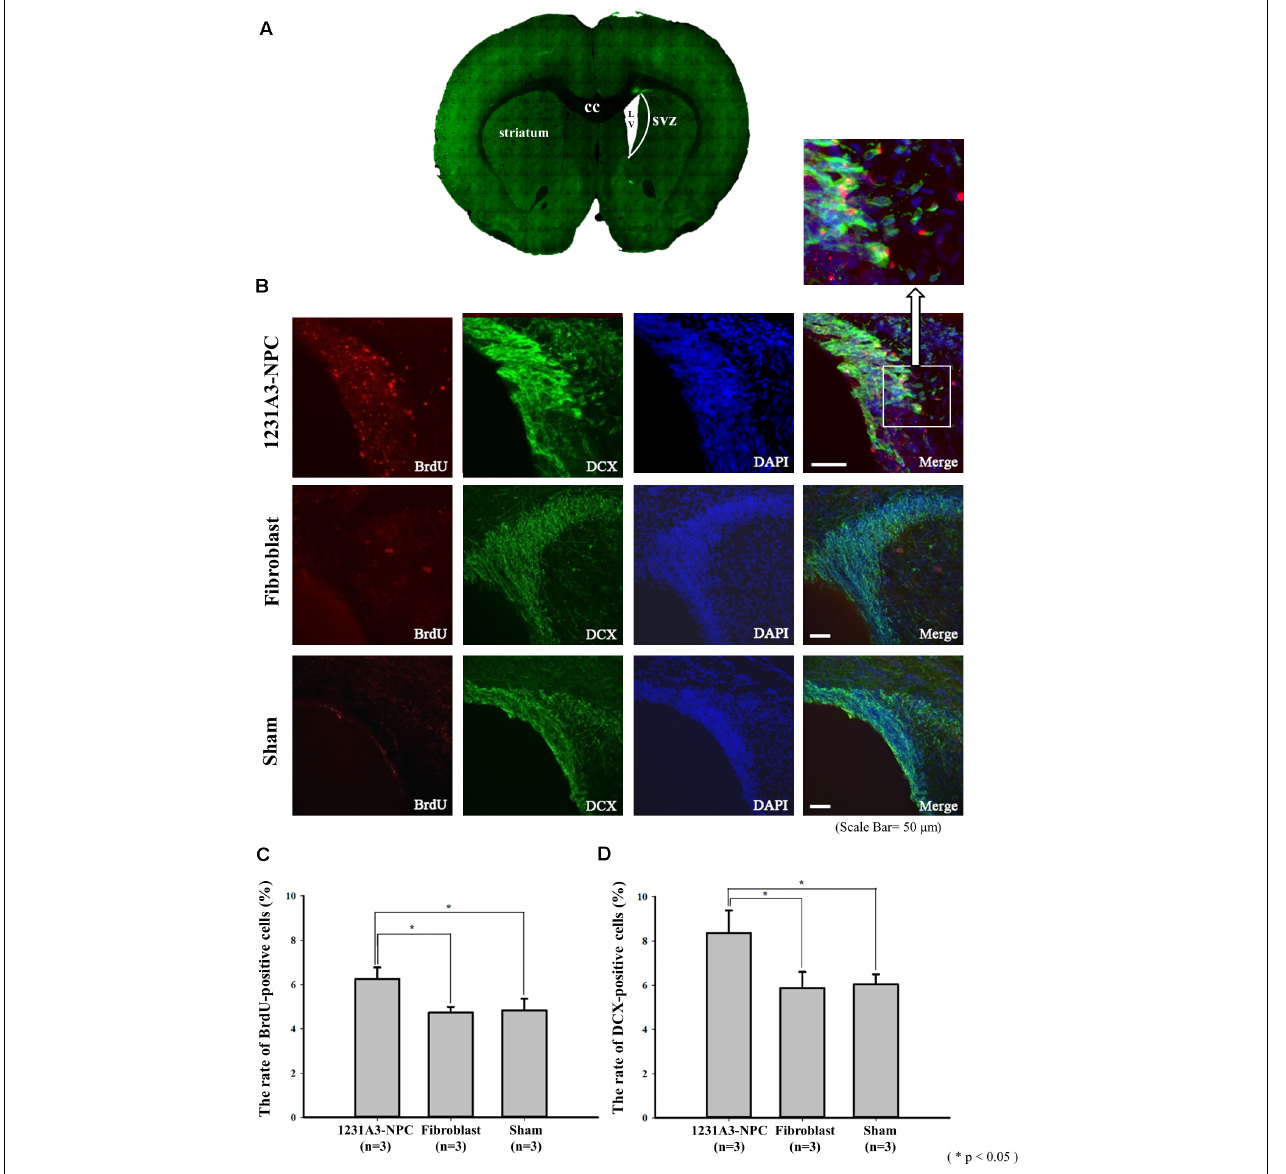
FIGURE 4 | IHC analysis showing the increase of endogenous neurogenesis by transplanted 1232A3-NPCs. (A) Coronal section of ipsilateral QA-lesioned rat model. (B) BrdU- and DCX-positive cells in ipsilateral SVZ 13 weeks post-TP. Scale bar = 50 µ m. Arrow indicates the enlarged image in the inset. (C,D) Bar graph showing the percentage of BrdU-positive cells and the percentage of DCX-positive cells ( n = 3 in each group). IHC, immunohistochemical; NPCs, neural precursor cells; QA, quinolinic acid; TP, transplantation BrdU, 5-bromo-2 (cid:48) -deoxyuridine; cc, corpus callosum; LV, lateral ventricle; SVZ, subventricular zone; * p <